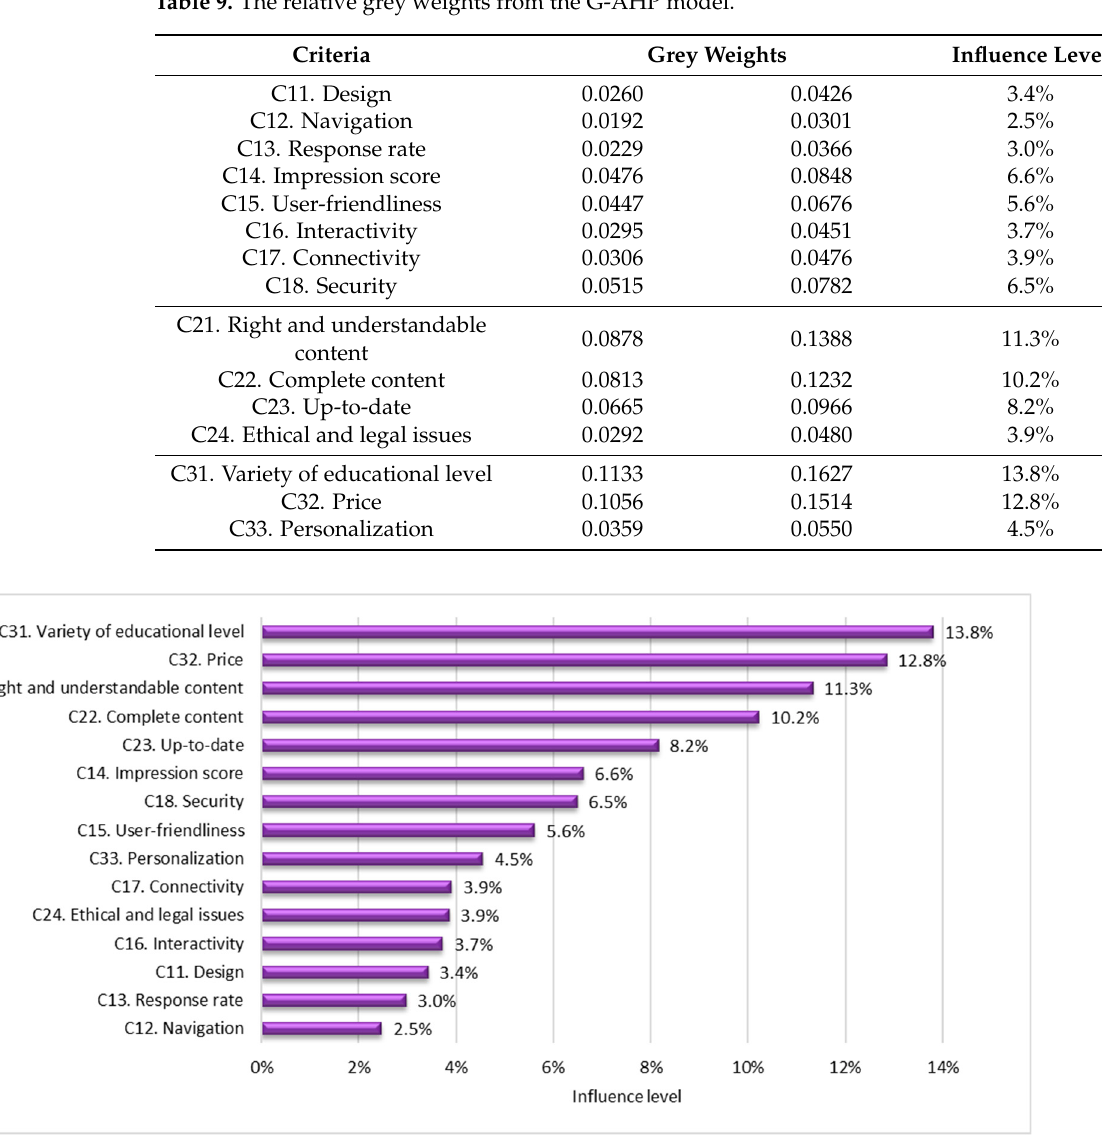
Table 9. The relative grey weights from the G-AHP model.